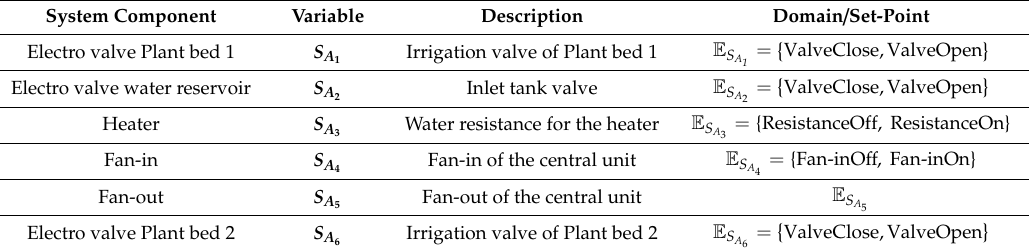
Table 1. System components description.